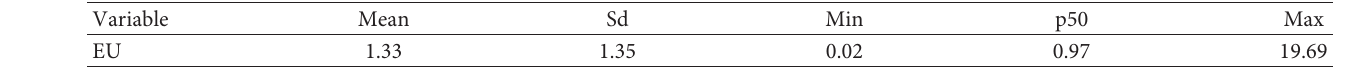
Table 7: Descriptive statistics of EU.